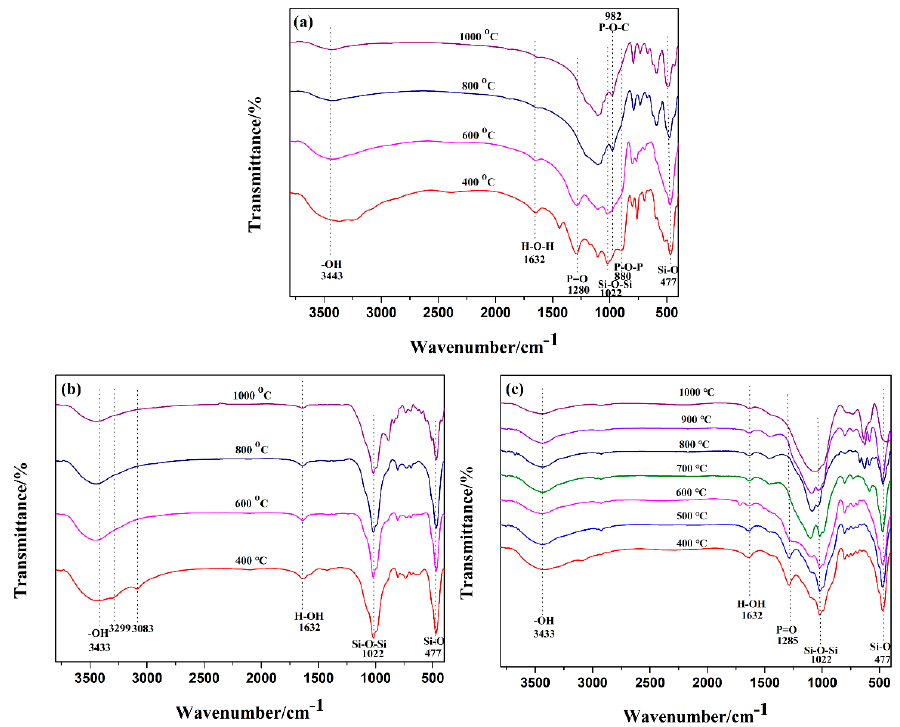
Figure 15. FTIR spectra of sample EVA1 ( a ), sample EVA2 ( b ), and sample EVA5 ( c ) sintered at different temperatures.